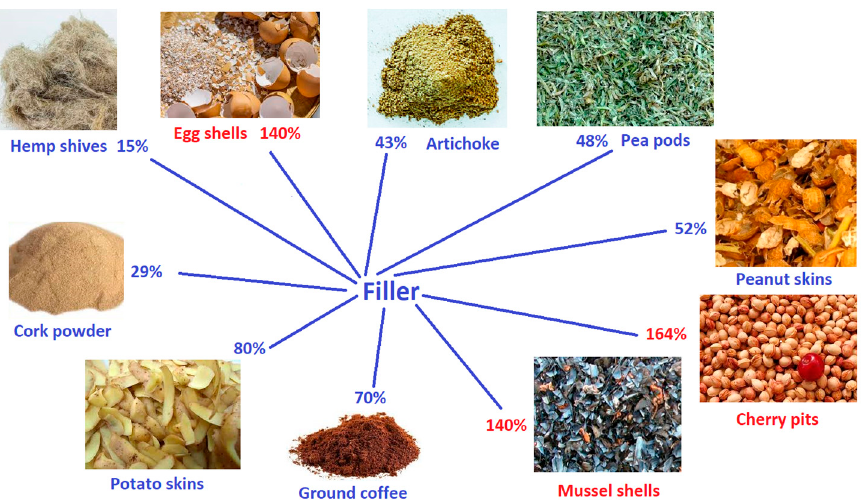
Figure 2. Amounts of powdered food wastes capable of being introduced into a poly(lactic acid) (PLA) matrix (elaborated from preliminary tests for [45]).